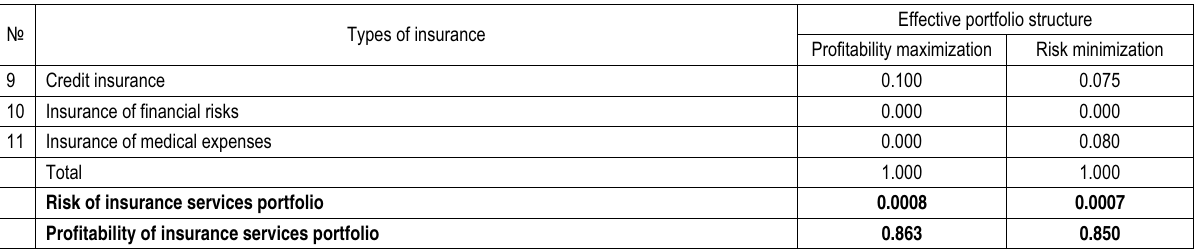
Table 6 (cont.). The optimal portfolio of insurance services of the voluntary types of insurance at maximum restrictions set at 15% for the share of one type of